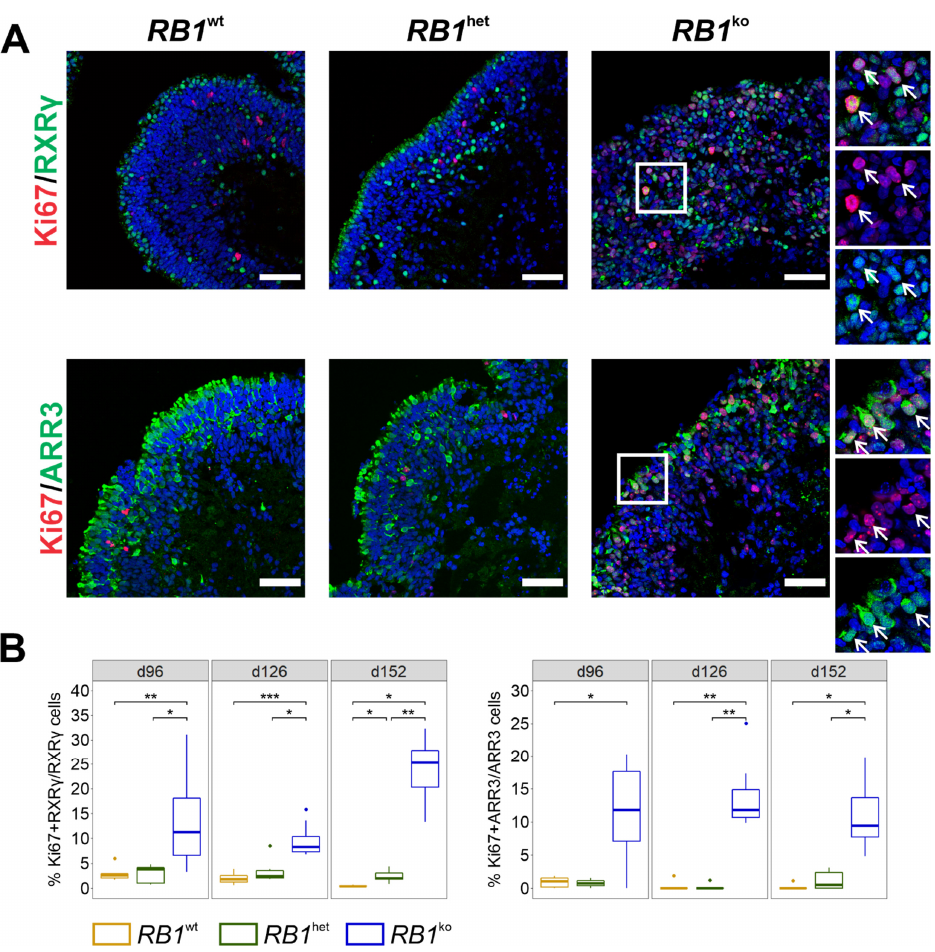
Figure 3. RB1 ko organoids develop proliferating RXR γ - or ARR3-positive cone photoreceptors. ( A ) Representative images of co-immunofluorescent staining of cone marker proteins RXR γ and ARR3 (green) with Ki67 (red) at d152 of differentiation. Arrows indicate double-positive cells. Nuclei were counterstained with DAPI (blue). Scale bar 50 μ m. ( B ) Quantification of cells staining positive for cone marker proteins and Ki67. The percentage of double-positive area normalized to cone marker-positive area is given. * p ≤ 0.05, ** p ≤ 0.01, *** p ≤ 0.001. LM-type cone photoreceptors are reportedly especially sensitive to loss of pRB [16,17]. Staining for LM-opsin and S-opsin revealed overall few positive cells with no significant difference in percentage in all three genotypes (Figure S8). Cells staining pos- itive in RB1 ko show less mature photoreceptor morphology, more nuclear than cyto- plasmic localization and lower overall signal intensity when compared to staining in RB1 wt and RB1 het (Figure S8). Co-staining of LM-opsin and S-opsin with Ki67 was ob-